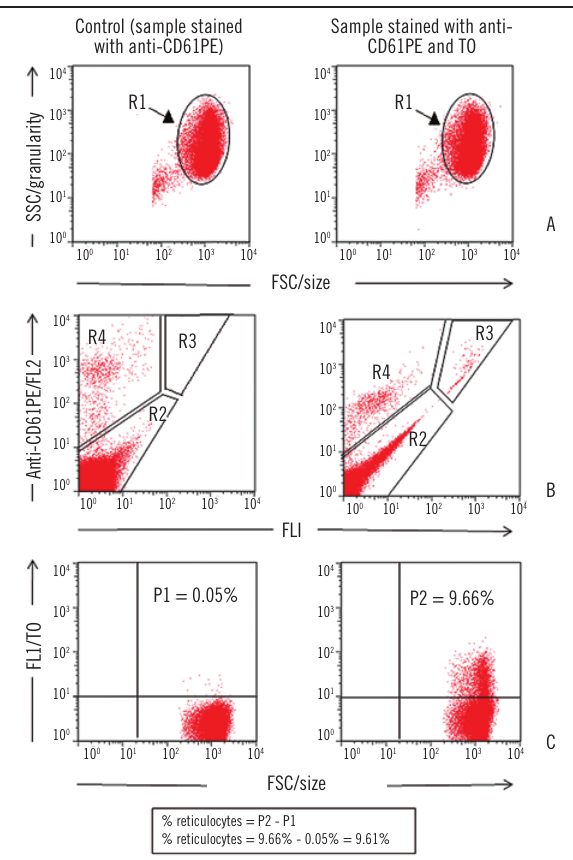
figurE 1 − Strategy of analysis for reticulocyte count by FC/TO and CD61PE A) selection of the population of interest, R1, based on morphometric aspects for the construction of graph B (FL1 × anti-CD61PE/FL2); B) identification of the homogeneous population, R2, and possible interferents – R3 and R4; C) quantification of the percentage of positive cells in the upper right quadrant (stained with TO) present in the R2 region – graph drawn with the combination of gates in R1 and R2